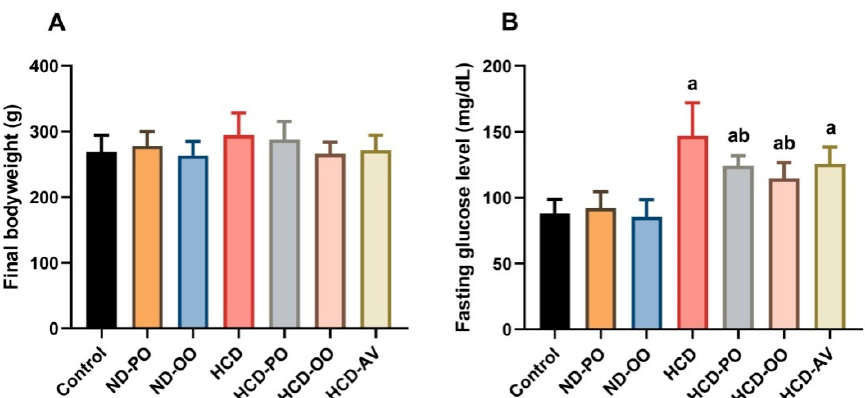
Figure 1. ( A ) Body weight and ( B ) serum glucose level following treatment with palm oil (PO), ol- ive oil (OO), or atorvastatin (AV) in high-cholesterol diet-induced hypercholesterolemia in rats. Data are expressed as the mean ± SD ( n = 7). Letters a and b indicate statistically significant differ- ences between control rats and hypercholesterolemia rats, respectively, at p < 0.05.